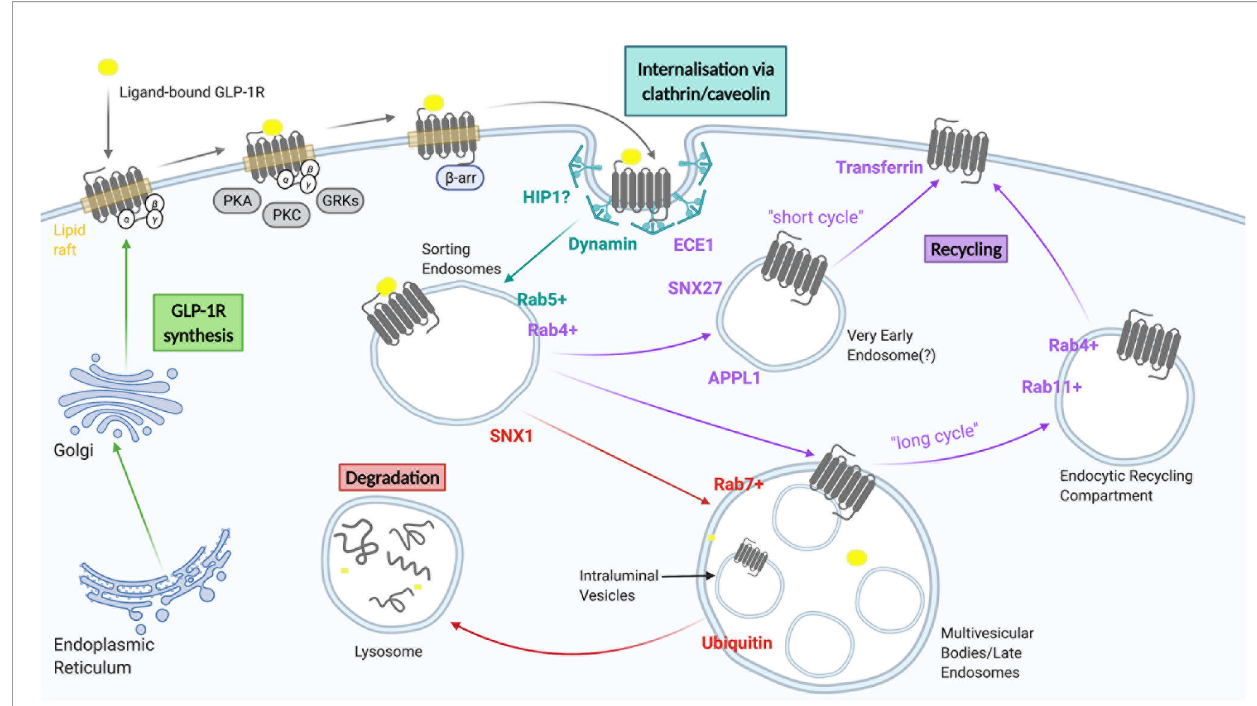
FIGURE 2 | A summary of GLP-1R traf fi cking. GLP-1 receptors are internalised through clathrin-dependent and/or clathrin-independent mechanisms and subsequently transported to sorting endosomes/early endosomes. From here they can either be recycled back to the plasma membrane via a fast recycling pathway (short cycle), a slow recycling (long cycle), or be targeted for degradation to lysosomes via multi vesicular bodies/late endosomes. Figure created using